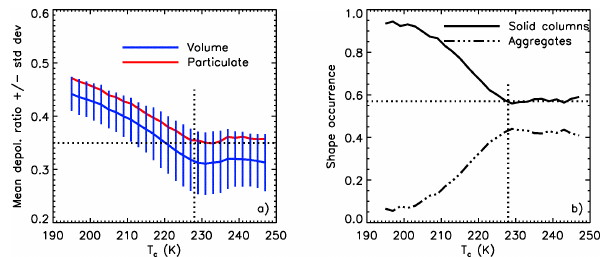
Figure 13. (a) Mean ± standard deviation volume (blue) and par- ticulate (red) depolarization ratio against T c ; (b) IIR retrieved shape occurrence against T c . The dotted lines indicate variations with T c discussed in the text. Same data set as in Fig.